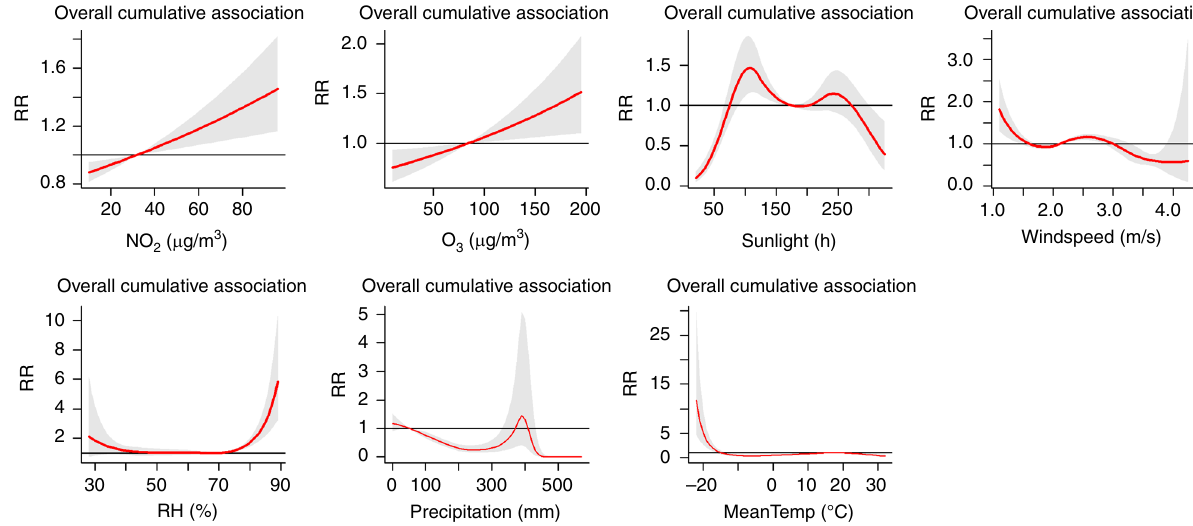
Fig. 7 Summary of cumulative exposure – response curves of scarlet fever incidence for air pollutants (NO 2 and O 3 ), meteorological factors (sunlight, wind speed, relative humidity, precipitation and mean temperature) at lag 0 – 15 months from 2013 to 2018. In addition to the adjusted air pollutants and meteorological conditions, the other adjusted variables in the model are temporal trend, the indicator variable of summer and winter breaks, quantile groups for average incidences, and incidence in the previous month. Source data are provided as a Source Data fi le.